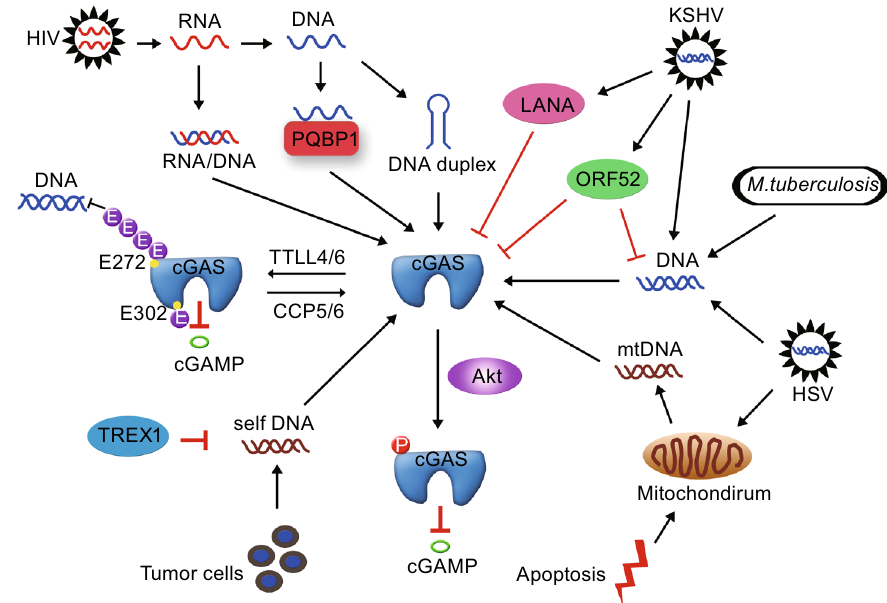
Figure 3. cGAS mediates dsDNA recognition and its regulation. cGAS is essential for immune recognition of foreign DNAs from various sources, such as DNA viruses, retroviruses and intracellular bacteria. cGAS activity is tightly regulated to prevent excessive activation. Besides host modi fi ers of cGAS, microbes possess various molecules to inhibit cGAS activity for their